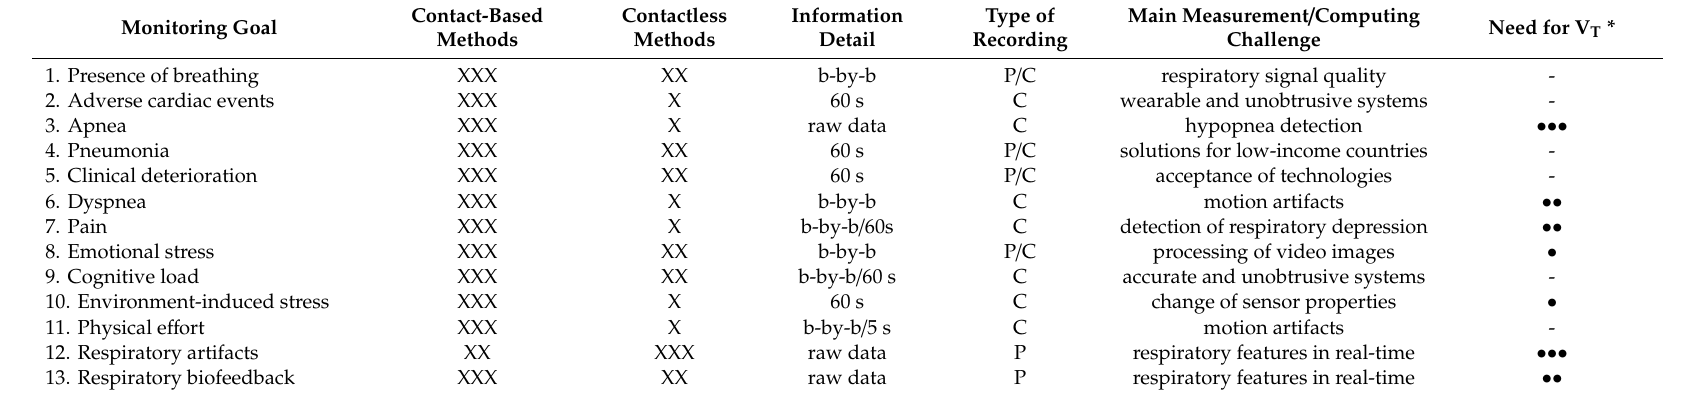
Table 1. Summary of measurement guidelines for each monitoring goal